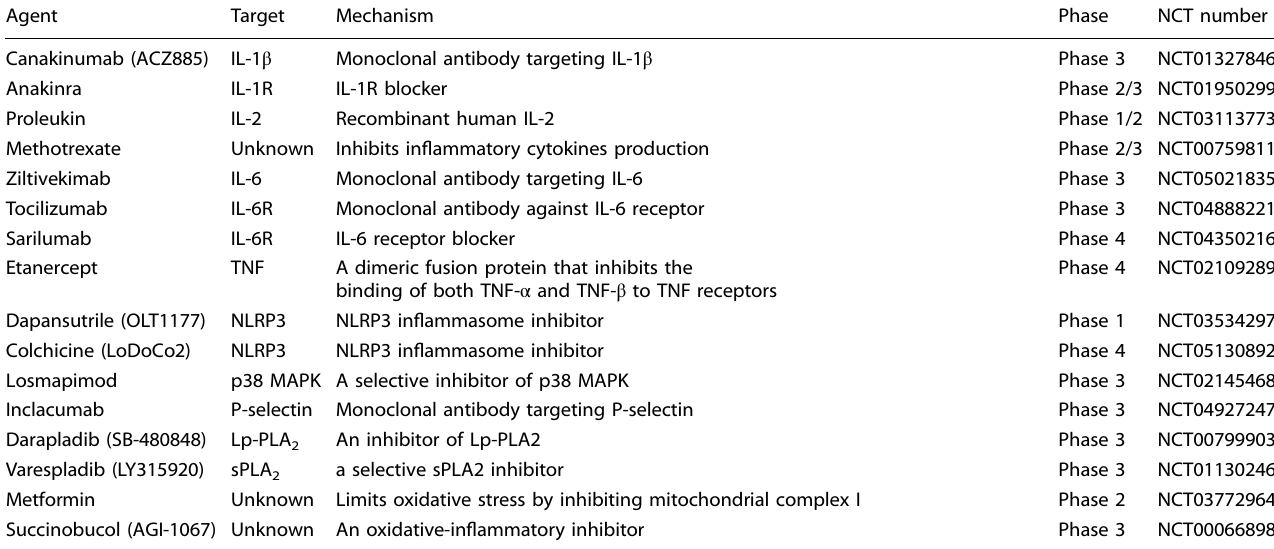
Table 2. Overview of clinical studies targeting in fl ammatory pathways in atherosclerosis